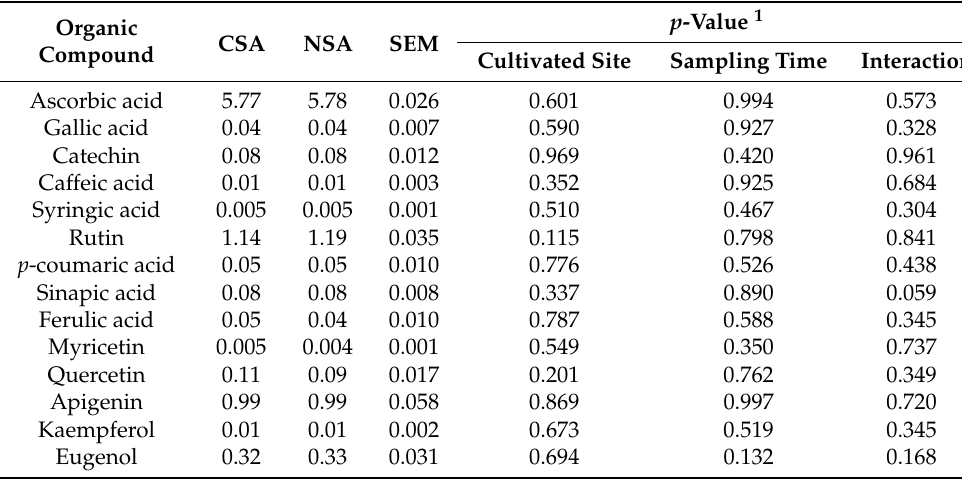
Table 2. Total contents of tannins, flavonoids, cinnamic acids, essential oils, and vitamins of commer- cial and noncommercial S. androgynus leaves (mg/g on dry weight